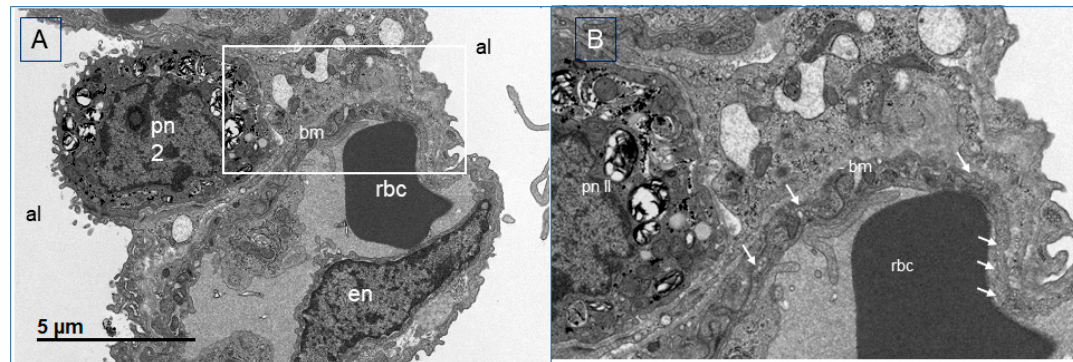
Figure 8. ( A , B ) Light microscopy of alveolar septa showed only a few apoptotic/karyorrhectic pneumocytes. The number of macrophages in the septa was not significant ( A ). Blood vessels showed a small number of neutrophils in the lumen and activated endothelial cells ( B ) (HE staining).